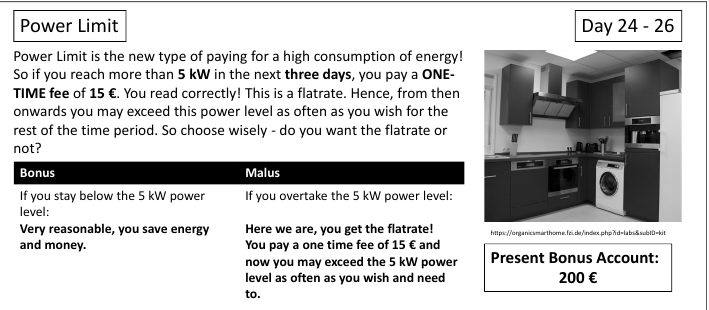
Figure 3. This message, called “Power Limit”, has been sent to the residents of the Energy Smart Home Lab (ESHL) in the morning of the 24th day, comprising the CtA, as well as the incentives formulated as bonus (positive) and malus (negative) consequences of performing the CtA or not. The box on the bottom right corner of the message indicates the present bonus account of the residents. Since the economic incentives started on Day 24 the box indicates the starting bonus of 200 e which the residents received not bound to any prior